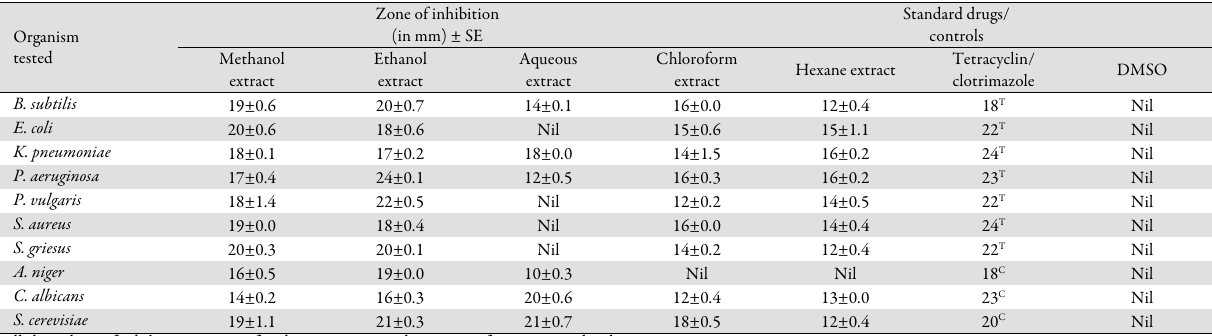
Table 2. MIC obtained with different extracts of Abitulon indicum roots Organism tested